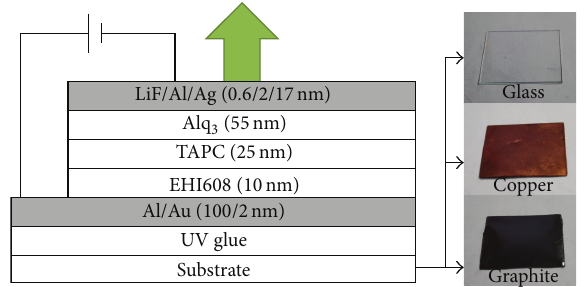
Figure 1: Component structure of TEOLED.